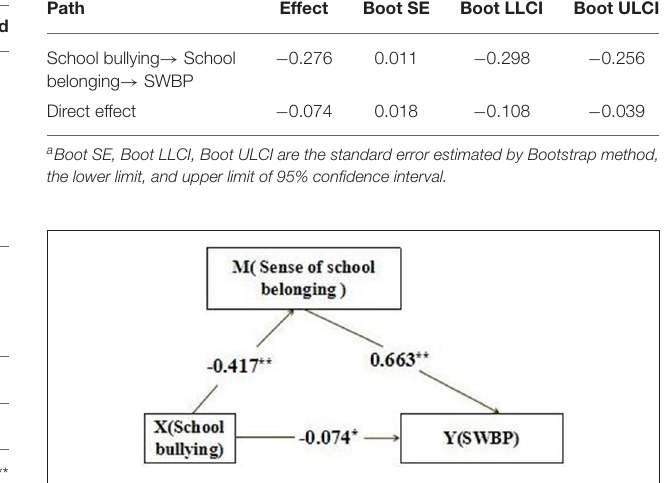
FIGURE 2 | The mediating effect of school belonging between school bullying and subjecting